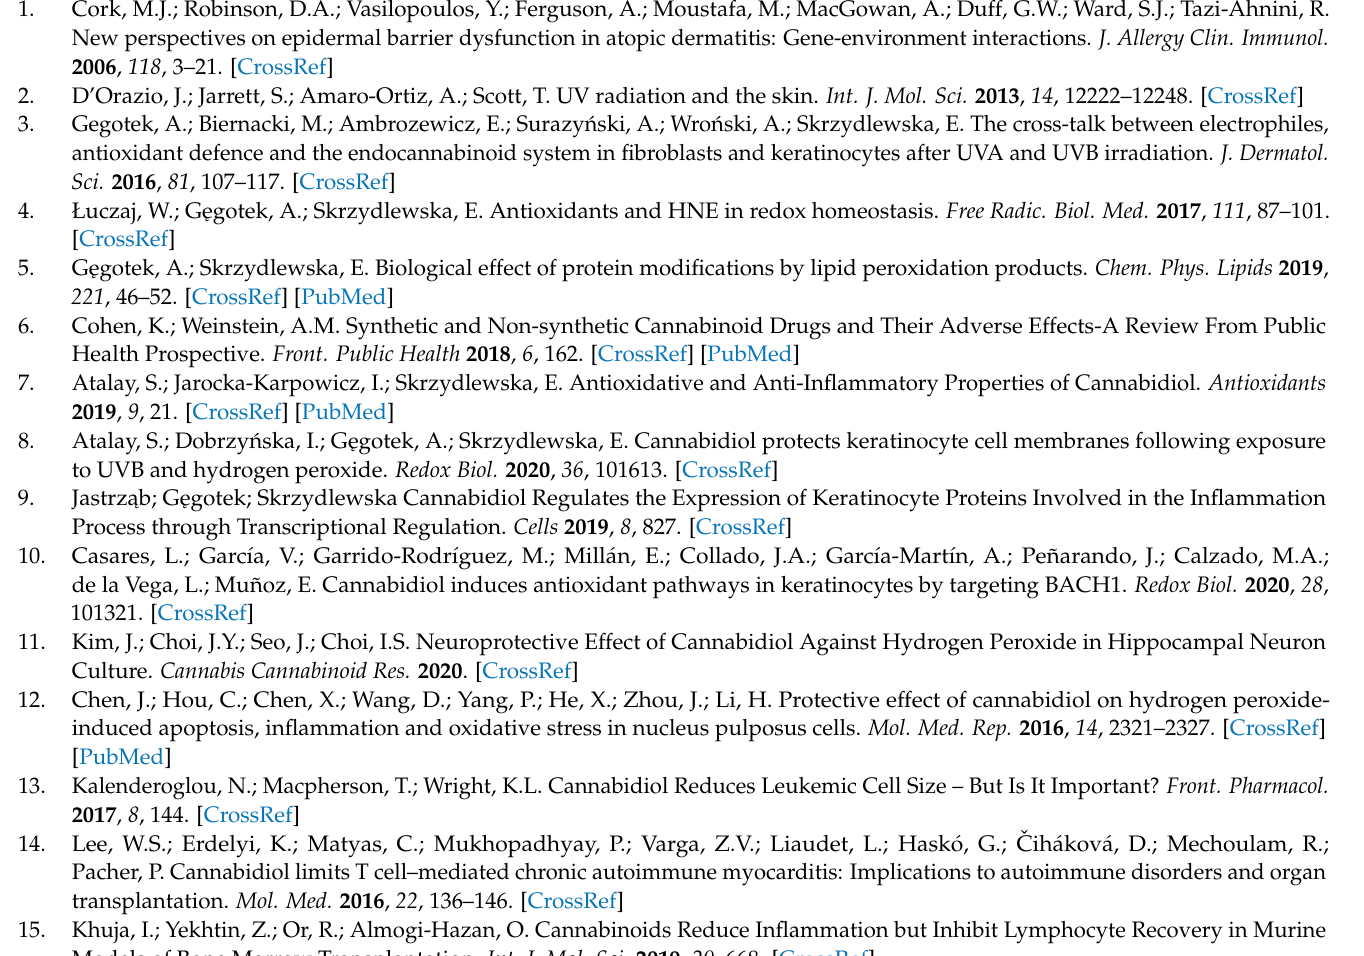
radiation. Figure S1: SDS–PAGE separation and staining with Coomassie Brilliant Blue R-250 of proteins from control keratinocytes and irradiated with UVA (30 J/cm 2 ), UVB (60 mJ/cm 2 ) or/and treated with cannabidiol (CBD, 4 µ M) in a three-dimensional (3D) culture